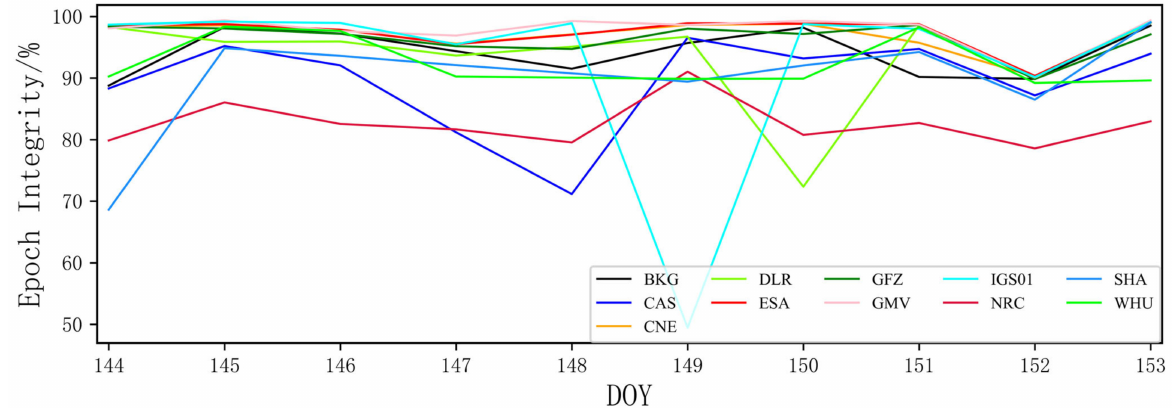
Figure 1. Integrity rate of State-Space Representation (SSR) products for all